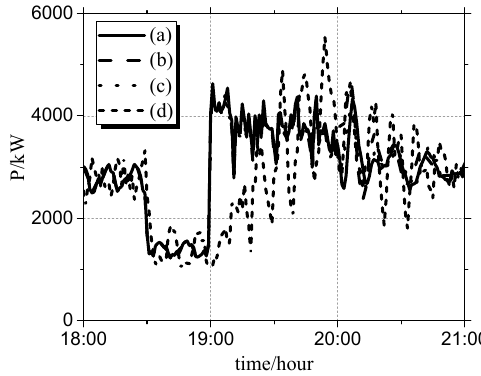
Energies 2019 , 12 FOR PEER REVIEW Figure 12. The load curve of the aggregated units under the demand response scheme.